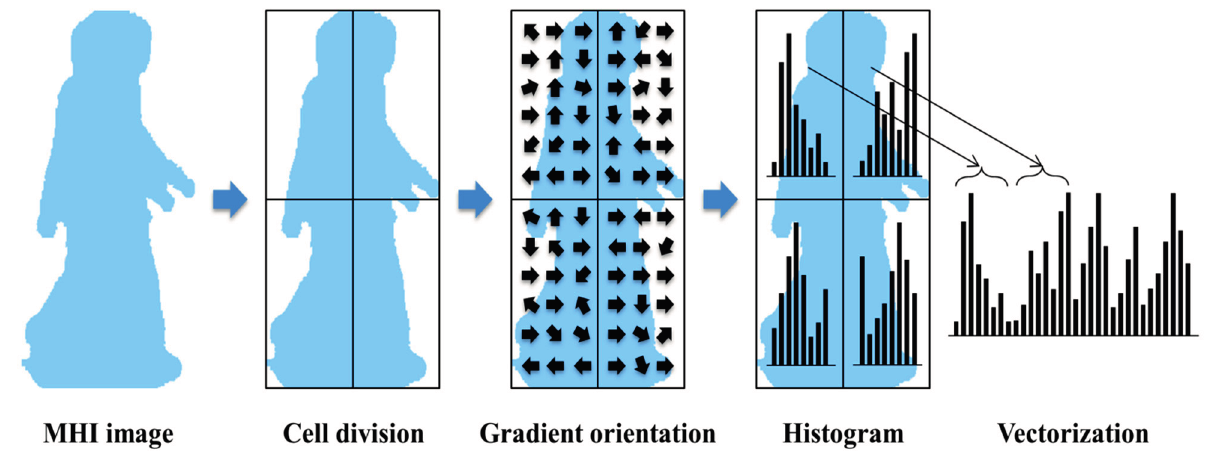
Figure 5. Extraction process of MHI-HOG feature